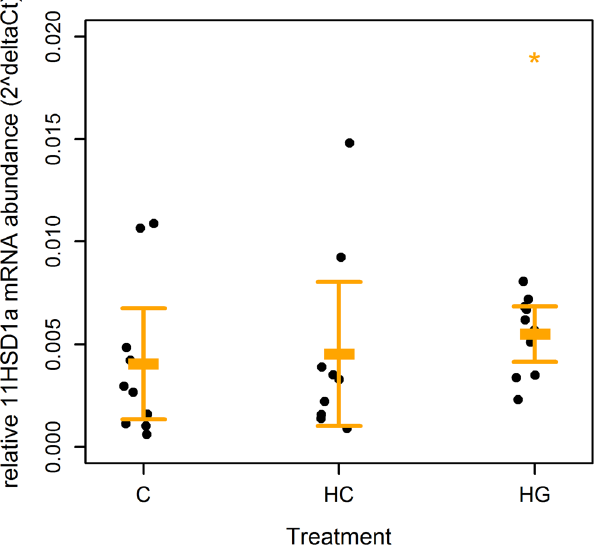
Figure 5. Effect of glucose and hydrocortisone on relative 11 β hsd1 mRNA abundance of grey seal blubber explants. Relative 11 β hydroxysteroid dehydrogenase 1 (11 β hsd1) mRNA abundance (2 Δ CT ) by 100 mg blubber tissue explants from grey seals (n = 10). Each point represents one animal. Bars represent mean ( ± s.d.). Tissues were minced and incubated in DMEM with 10% fetal bovine serum 5% penicillin and streptomycin, and glutamine. Explants from the same animal were supplemented with 5.5 mM glucose (C), 25 mM glucose (HG) or 5.5 mM glucose + 500 nM hydrocortisone (HC). Tissues were harvested after overnight (24 h) incubation. * Indicates where treatment was significantly different from C (LME: p < 0.001).